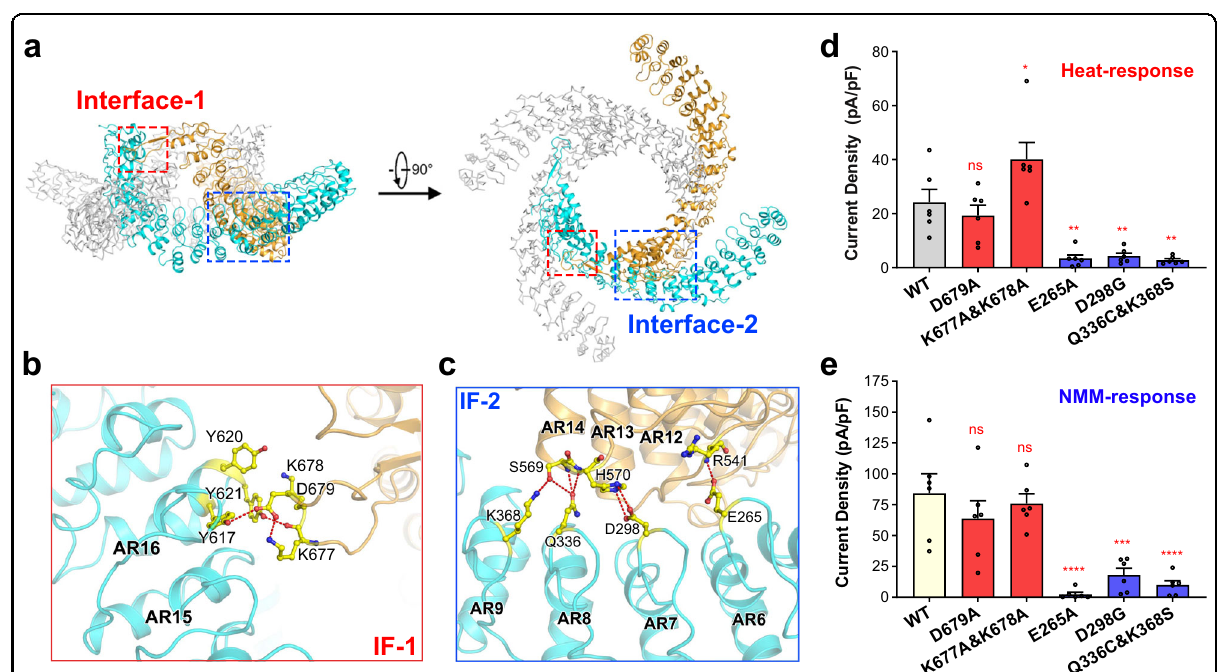
Fig. 5 ARD adopts a unique architecture in the state-1 structure of the dTRPA1-A isoform. a Two interfaces, interface-1 and interface-2, are observed between adjacent subunits in the cytosolic domain of the dTRPA1-A state-1 structure, as indicated by red and blue boxes, respectively. b Zoomed view of interface-1 (IF-1) of the dTRPA1-A state-1 structure. Two neighbouring subunits are shown in cyan and light orange. Residues at the interface are shown in sticks and the polar contacts are indicated by red dashed lines. c Zoomed view of interface-2 (IF-2) of the dTRPA1-A state- 1 structure. d Heat-induced current densities for WT dTRPA1-A and the IF mutants. Independent experiments were repeated six times for each construct ( n = 6 for all). ns not signi fi cant, * P = 0.018, and ** P < 0.003 for WT versus mutants (one-way ANOVA with Dunnett ’ s multiple comparisons test). Data are mean ± s.e.m. e NMM-induced current densities at − 60 mV for WT dTRPA1-A and the IF mutants. Independent experiments were repeated six times for each construct ( n = 6 for all). ns not signi fi cant, *** P = 0.0002, and **** P < 0.0001 for WT versus mutants (one-way ANOVA